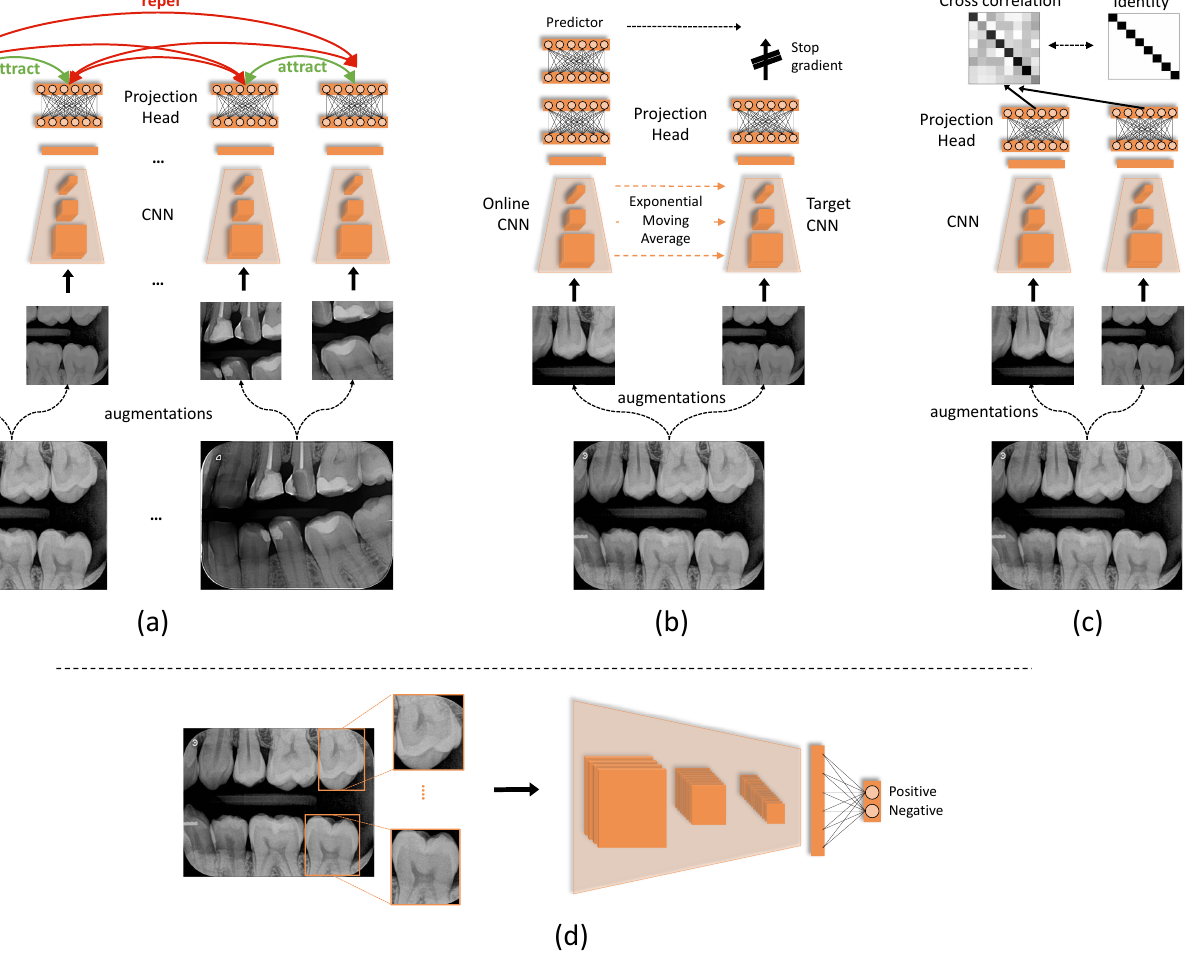
Figure 2. Illustration scheme of the three self-supervised algorithms and how to fine-tune the resulting encoder CNN. ( a ) SimCLR relies on attracting the views of each image together and repelling them from the views of other images. ( b ) In BYOL the target network calculates moving averages of the online network, which is updated with loss gradients. ( c ) Barlow Twins computes the cross- correlation matrix of two batches of image views and minimizes its difference to the identity